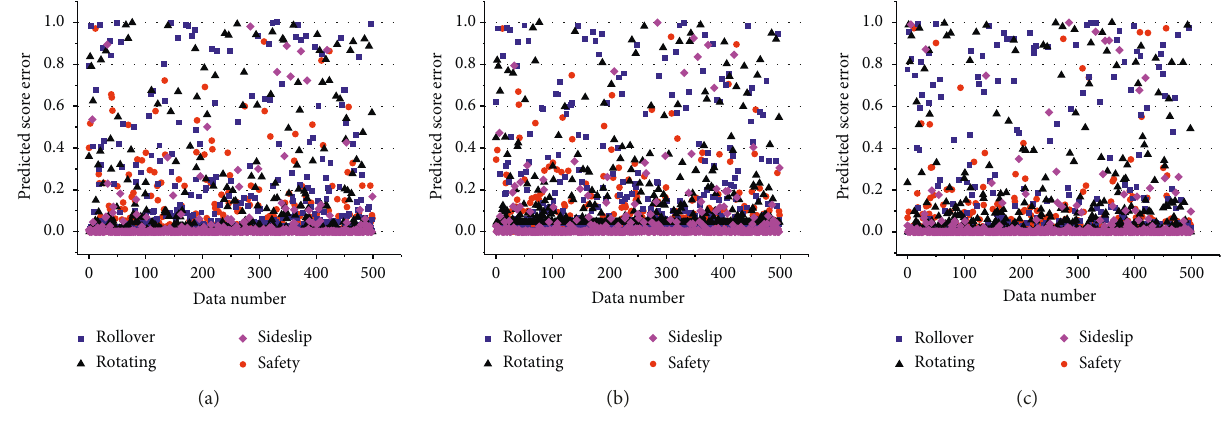
Figure 12: Prediction errors of models. (a) 4-8-4. (b) 4-3-3-4. (c) 4-15-15-4. Table 6: Statistical analysis of predicted score error.